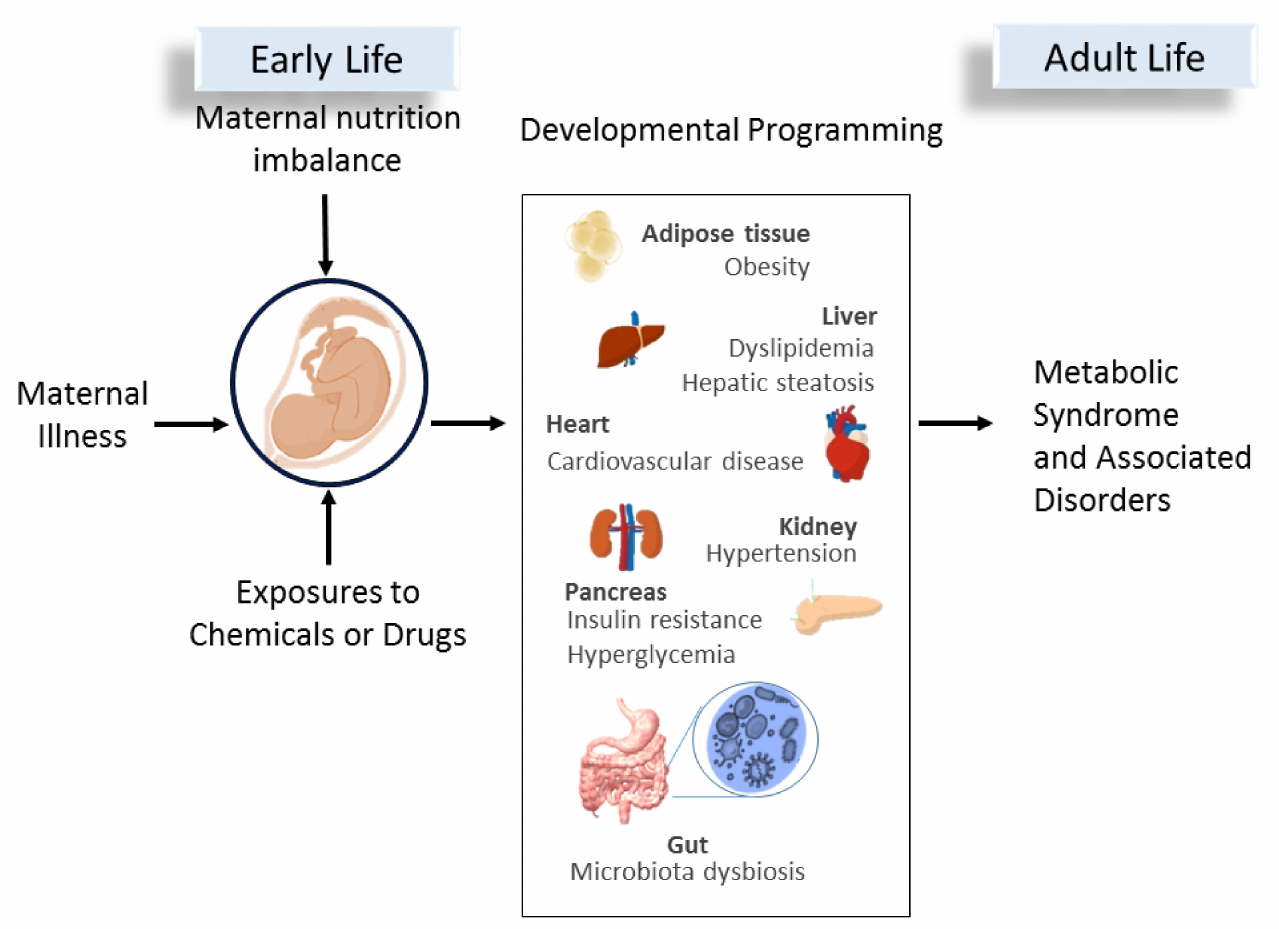
Figure 1. A schematic depiction delineating early-life environmental cues that may cause the de- velopmental programming in different organ systems leading to MetS and associated disorders in adult